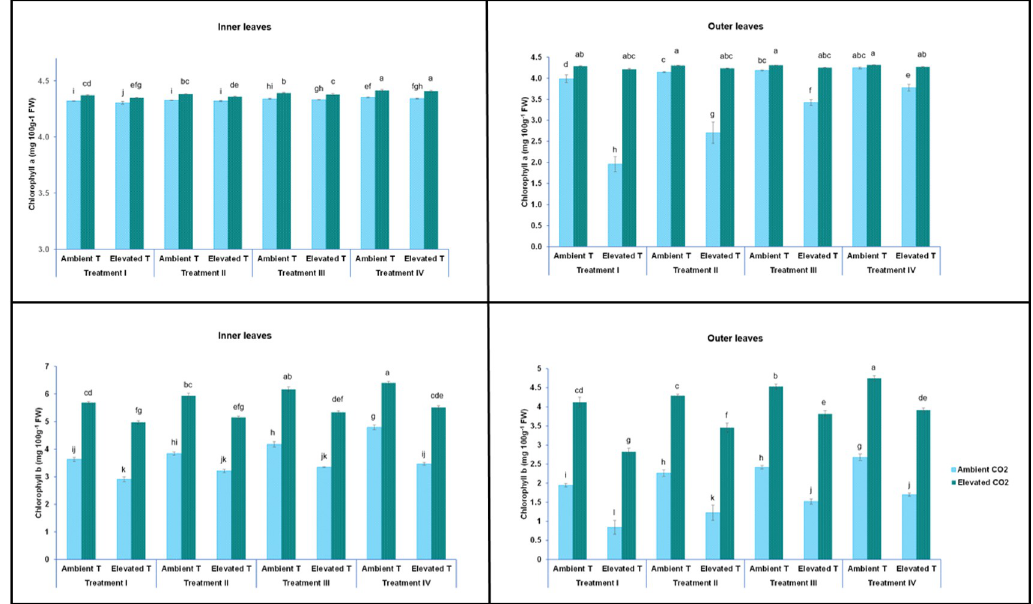
Fig 4. Effect of short-term heat stress on concentrations of chlorophyll a in inner (A) and outer (B) leaves and chlorophyll b (mg L -1 cm -2 ) in inner (C) and outer (D) leaves of the baby-leaf lettuce cv Derbi at different levels of CO 2 and at four different NO 3- / NH 4+ treatments. Different letters are significantly different according to Tukey’s test at p �